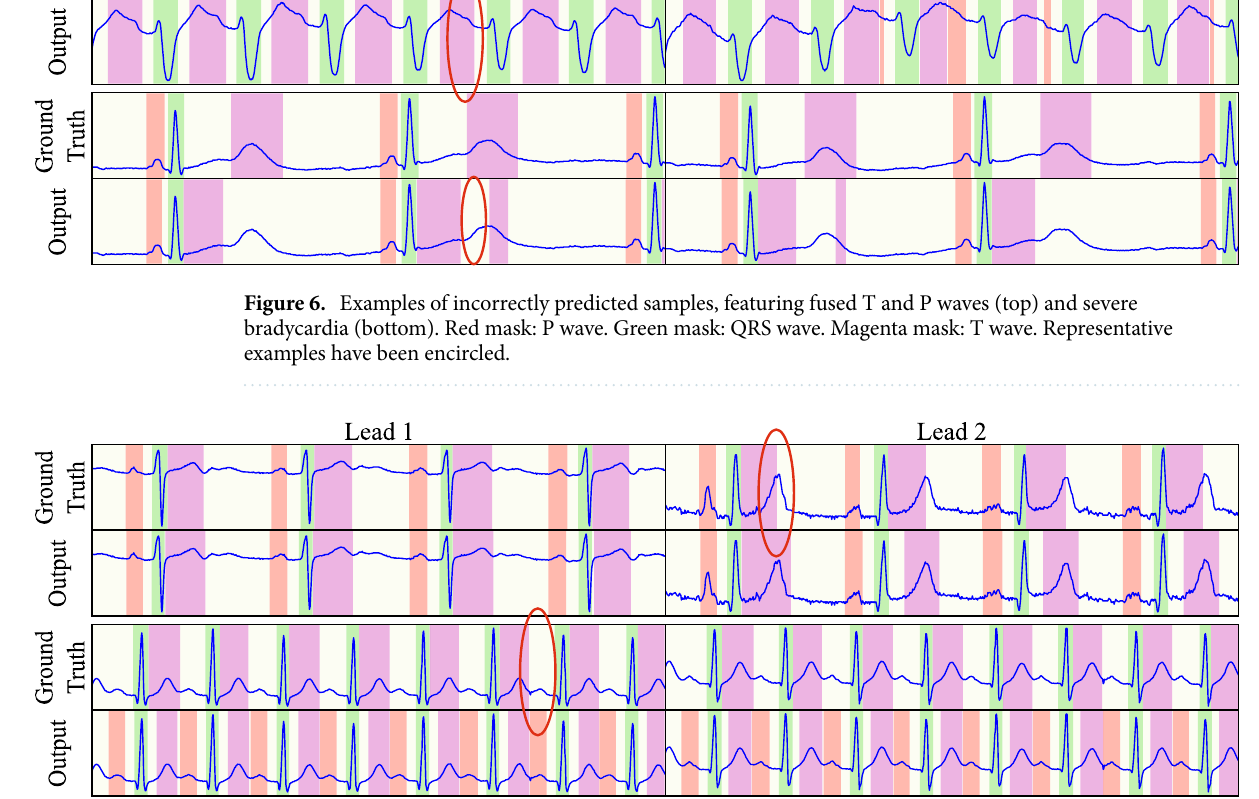
Figure 7. Examples of incorrectly annotated ground truth, demonstrating incorrect T offset location (top) and missed P waves (bottom). Red mask: P wave. Green mask: QRS wave. Magenta mask: T wave. Representative examples have been